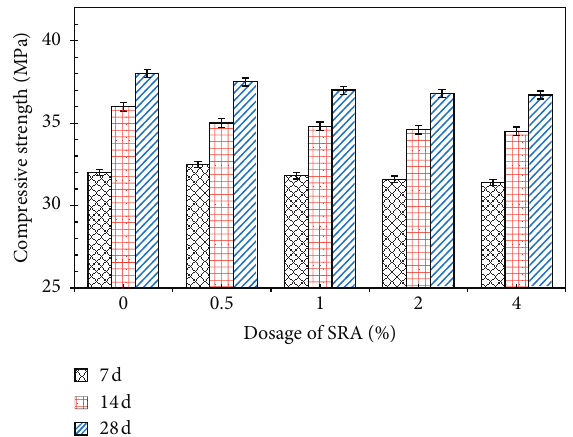
Figure 11: Effect of SRA dose on the compressive strength of concrete.